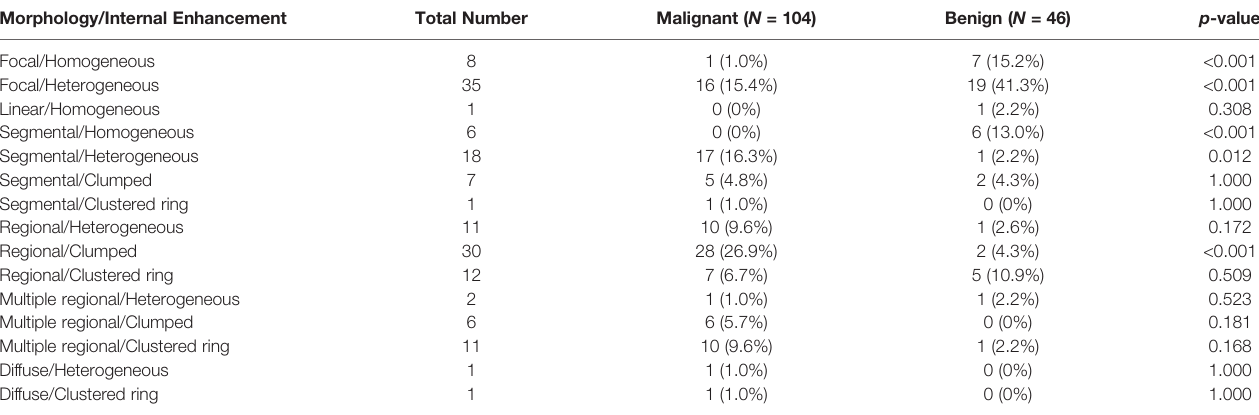
TABLE 3 | Combined morphology distribution and internal enhancement pattern in malignant and benign groups. Morphology/Internal Enhancement